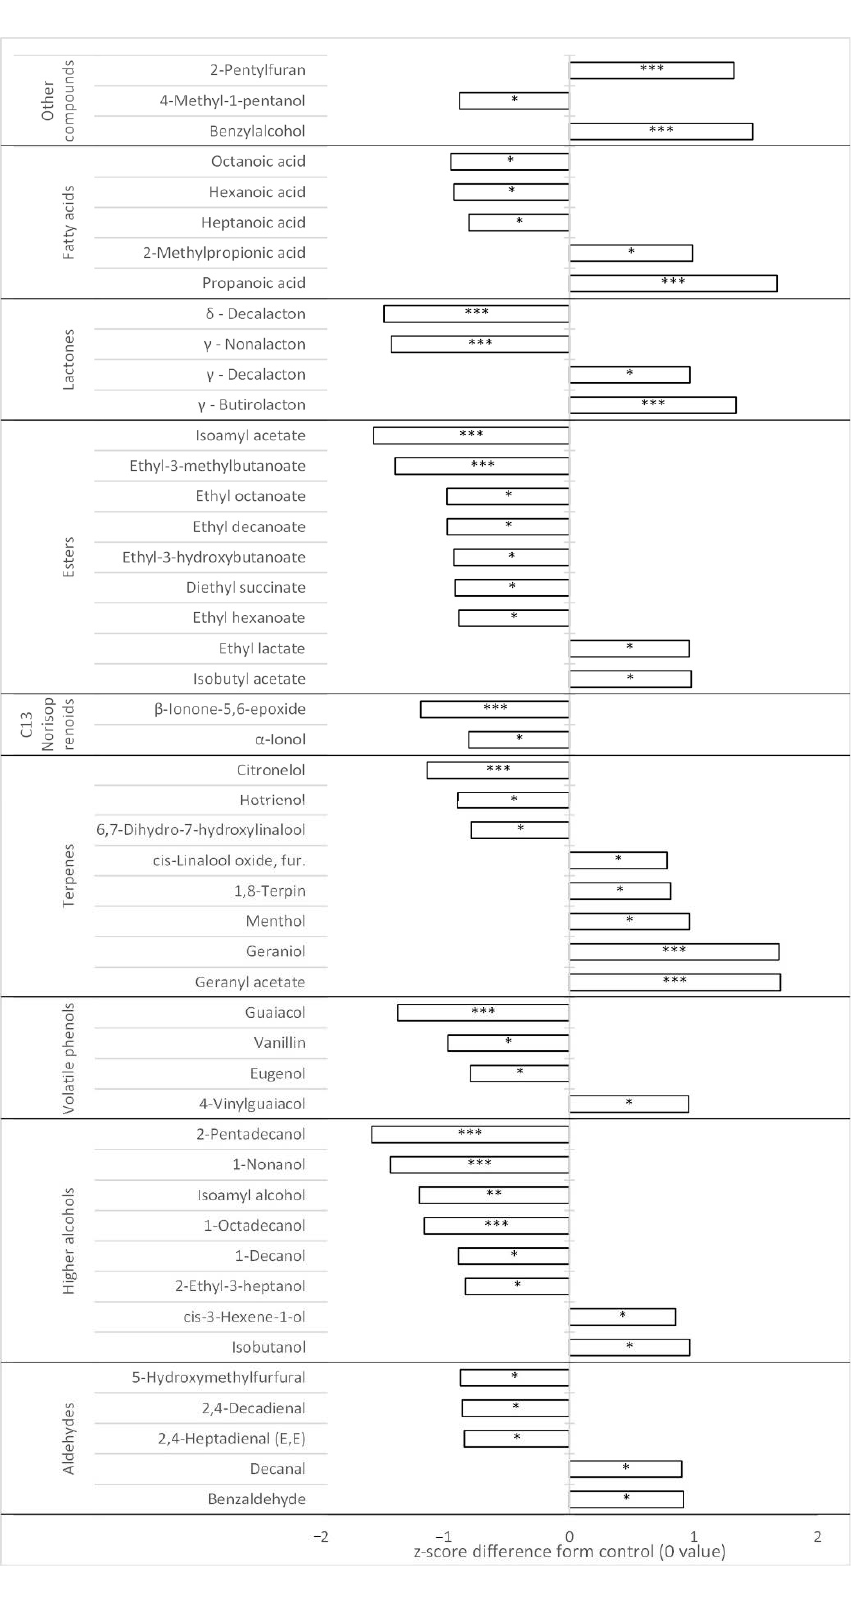
Figure 1. Common significant effects of L. thermotolerans yeast in sequential fermentation with S. cerevisiae against control wines expressed as the difference of z-score from control (presented as 0 value) for all four cultivars using z-score standardization within cultivars for volatile aroma compounds with significant effect only; significance level: * p < 0,05, ** p < 0.01 and *** p < 0.001 with two-sided Dunnett test.